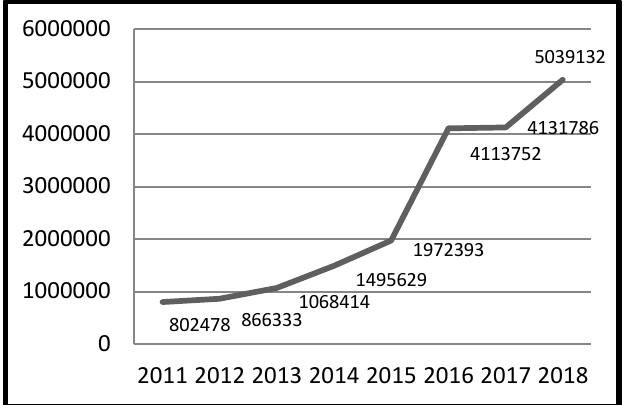
Figure 1. Data of Tourist visitation Number in Banyuwangi